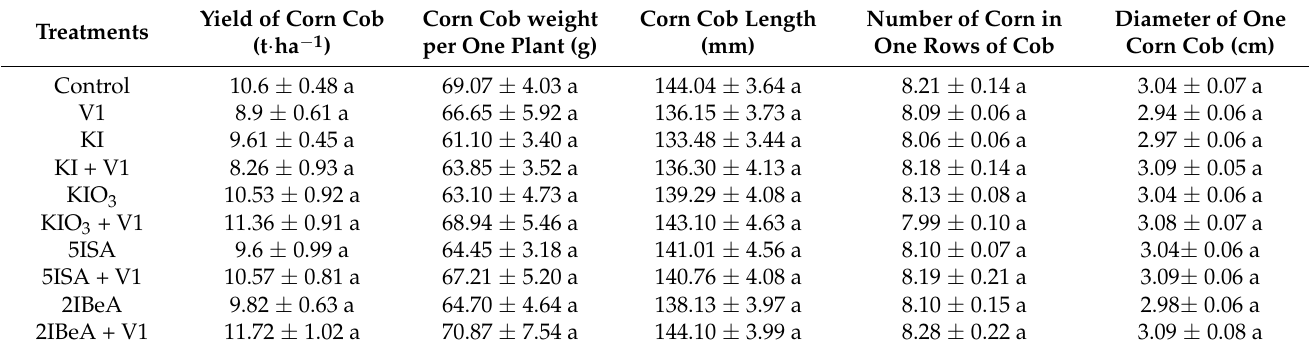
Table 3. Results of yield of corn cob, corn cob weight per one plant, corn cob length, number of corn kernels in one row of cob and diameter of one corn cob in experiment No.